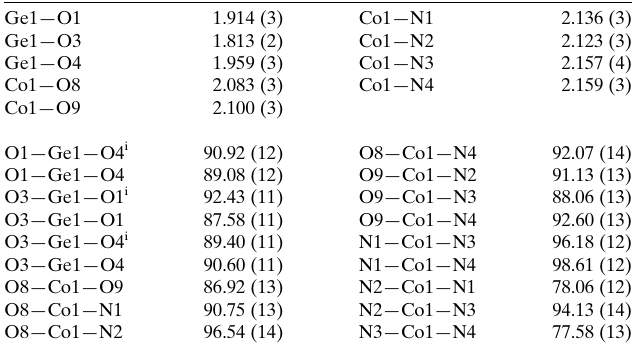
Table 1 Selected geometric parameters (A˚ , (cid:4) ).